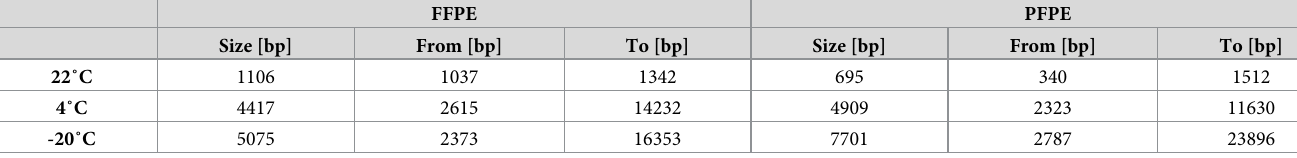
Table 1. Average DNA molecule size from rat PET blocks stored at different temperatures for 9 years.